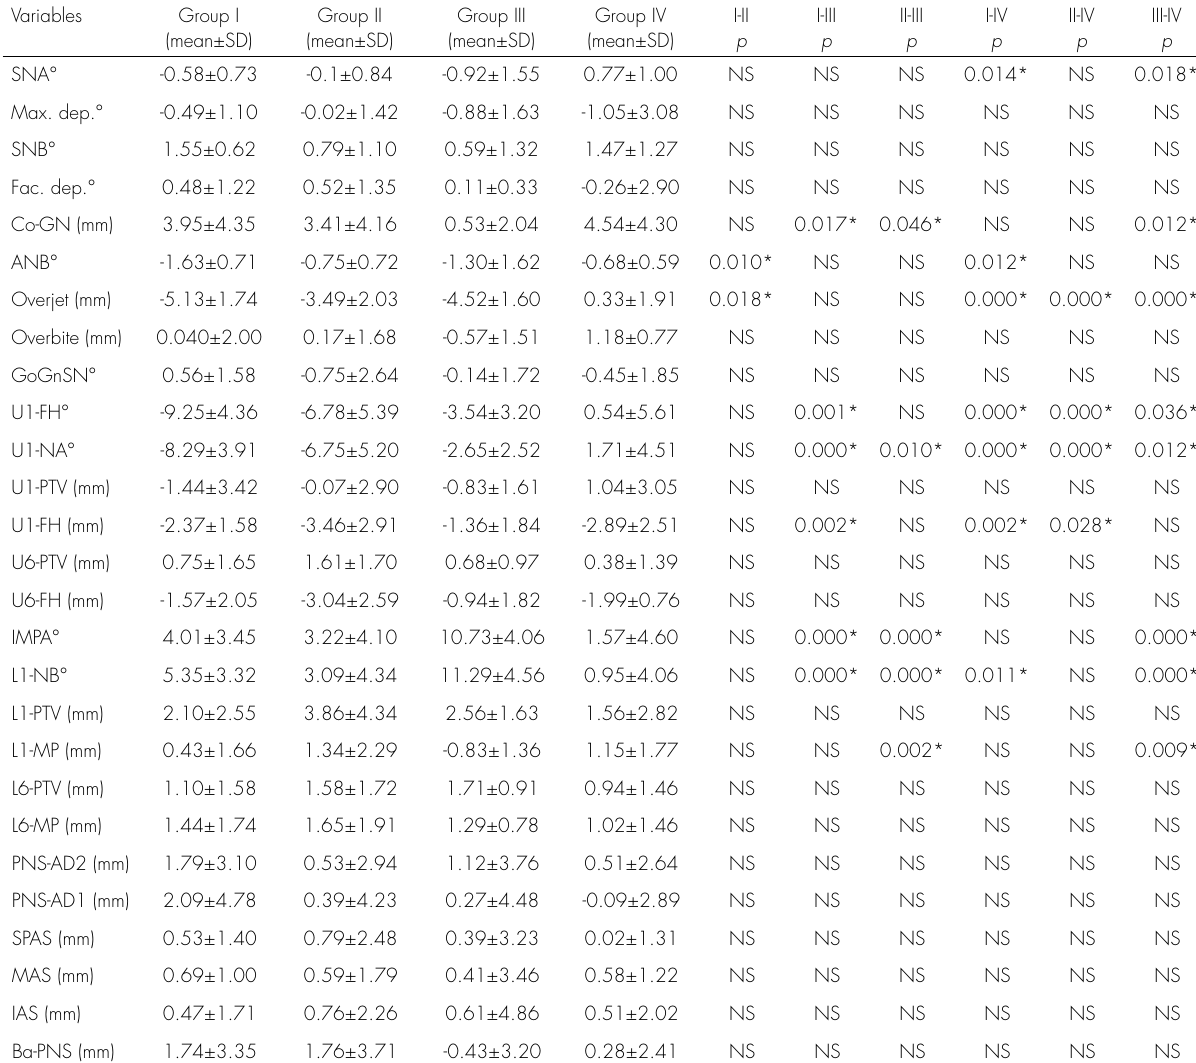
Table III. Comparison of measurement changes during treatment in each